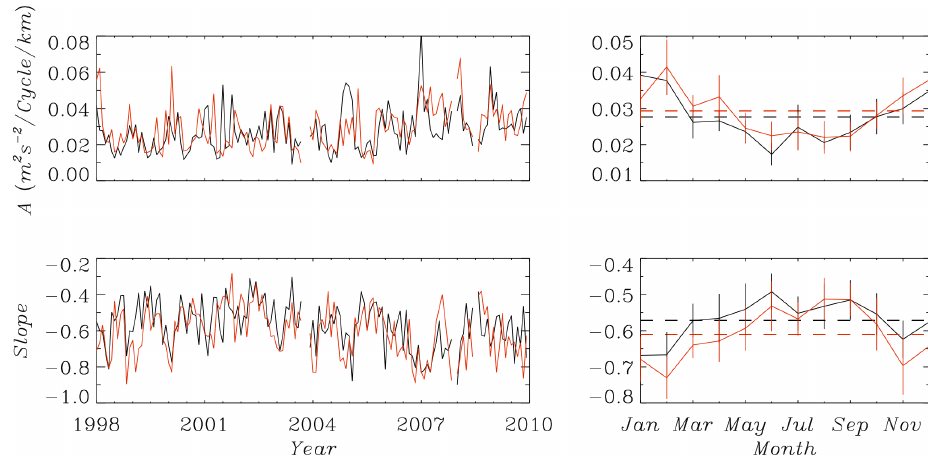
Figure 6. Monthly averaged (left panels) spectral magnitudes (upper panels) and slopes (bottom panels) of the vertical wind fluctuation at different local times in the troposphere. The gaps mean no measurements. The annual variations of these spectral parameters are illustrated in the right panels. The black and red curves denote, respectively, the spectral parameters at 00:00UT (16:00LT) and 12:00UT (04:00LT). The horizontal and vertical lines in the right panels represent the mean values and standard deviations, respectively.